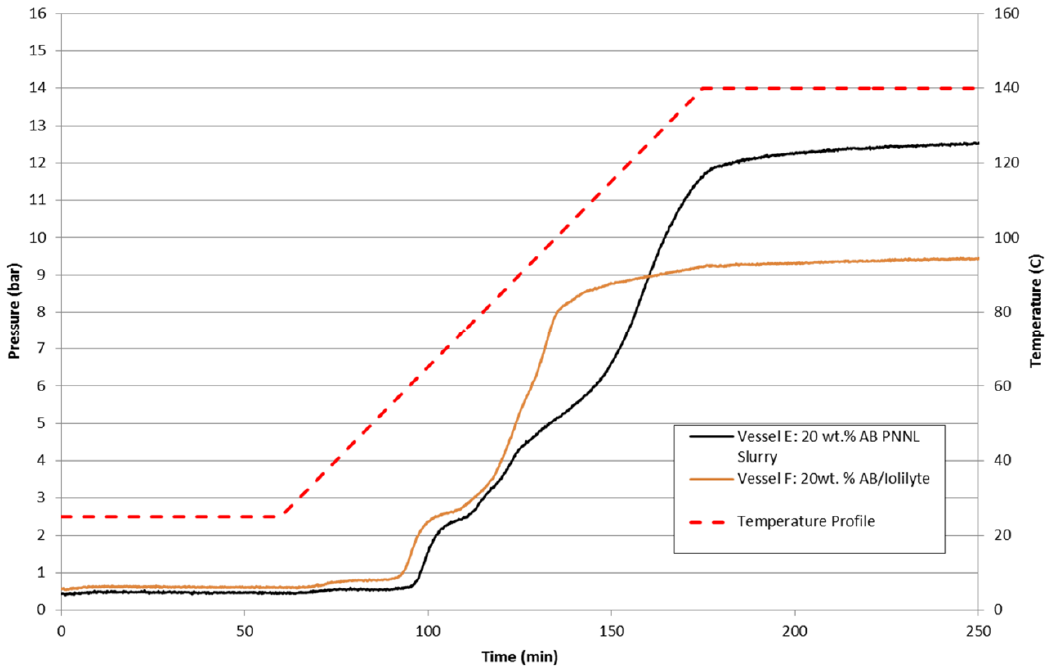
Figure 19. Batch reactor results of 20 wt% ammonia borane slurries in AR−20 silicone oil (black) and ionic liquid IoLiLyte (orange).